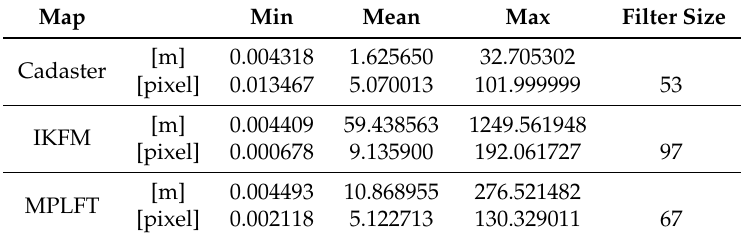
Table 3. Evaluation of the thickness of the objects to be removed and the corresponding filter size.